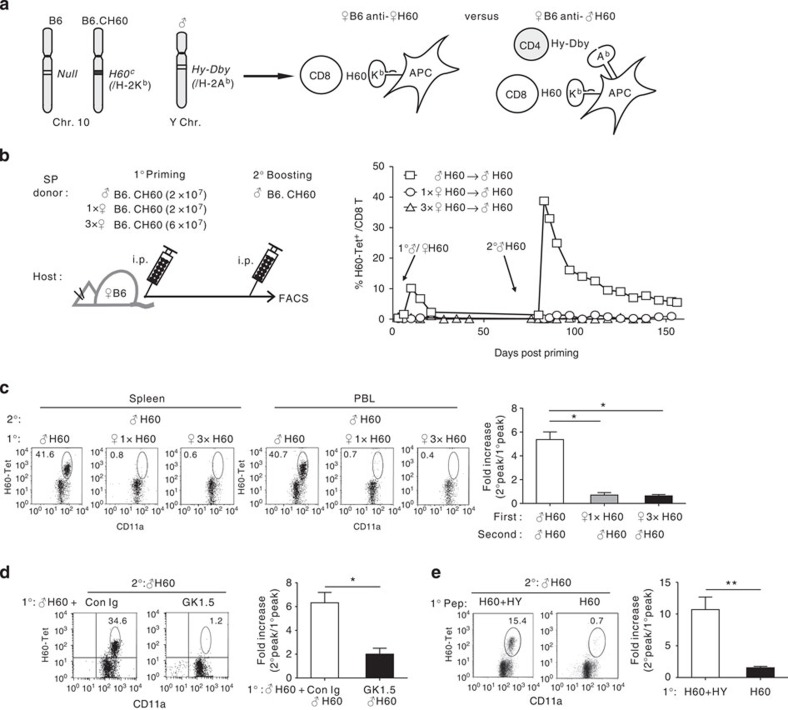
Impairment of memory expansion of H60-specific CD8+ T cells activated in the absence of CD4+ T-cell help.(a) Diagrams of experimental systems using B6.CH60 mice. The B6 mouse strain has null expression from the H60 locus, whereas the B6.CH60 strain expresses H60C allele at the locus, which produces the H-2Kb-restricted CD8 epitope to activate T cells of B6 mice. The Hy-Dby gene on the Y chromosome encodes the CD4 epitope presented by H-2Ab. Priming of female B6 mice with female or male cells from B6.CH60 mice induces the helper-deficient or helped response for H60, respectively. (b) Female B6 mice were primed with total splenocytes of female B6.CH60 mice at a 1 × dose (2 × 107) or a 3 × dose (6 × 107), or with male (2 × 107) B6.CH60 spleen cells, and then boosted with male B6.CH60 spleen cells (2 × 107). Pooled PBLs from three immunized mice were analysed periodically using flow cytometry after staining with H60 tetramers, and anti-CD11a and anti-CD8 monoclonal antibodies (mAbs). The frequencies of H60-tetramer-binding cells in blood CD8+ T cells were then plotted. (c) Flow cytometric data of splenocytes and PBLs obtained on day 7 post boosting are shown after CD8+ gating, with percentages of the H60-tetramer-binding cells in CD8+ T cells denoted. The fold increase in the frequency of the secondary peak (day 7 post boosting) relative to that of the primary peak (day 10 post priming) is shown. (d) Female B6 mice treated with GK1.5 (for CD4 depletion) or control Ig were primed with male B6.CH60 cells. (e) Female B6 mice were primed with female syngeneic cells loaded with the H60 peptide alone or combined with the HY-Dby peptide. Then, these primed mice (d,e) were boosted with male B6.CH60 cells 40 days later. Representative data from flow cytometric analysis of PBLs from the boosted mice on day 7 post boosting are shown, with the plots of the fold increase in the frequency. All data (b–e) are representative of more than three independent experiments (n=3 per group per experiment). Data are presented as means±s.e.m. *P<0.05, **P<0.01 determined by Student's t-test.